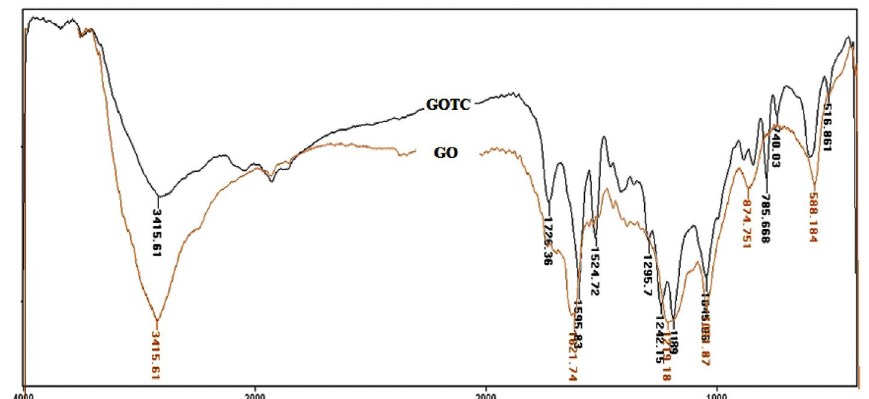
Fig. 1. FT-IR spectra of GO and